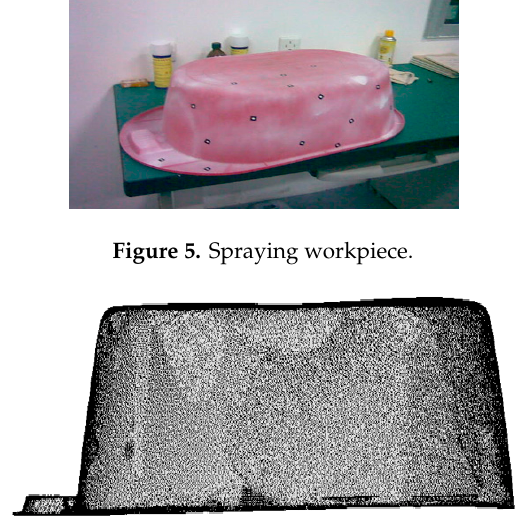
Figure 6. Point cloud model of the workpiece.